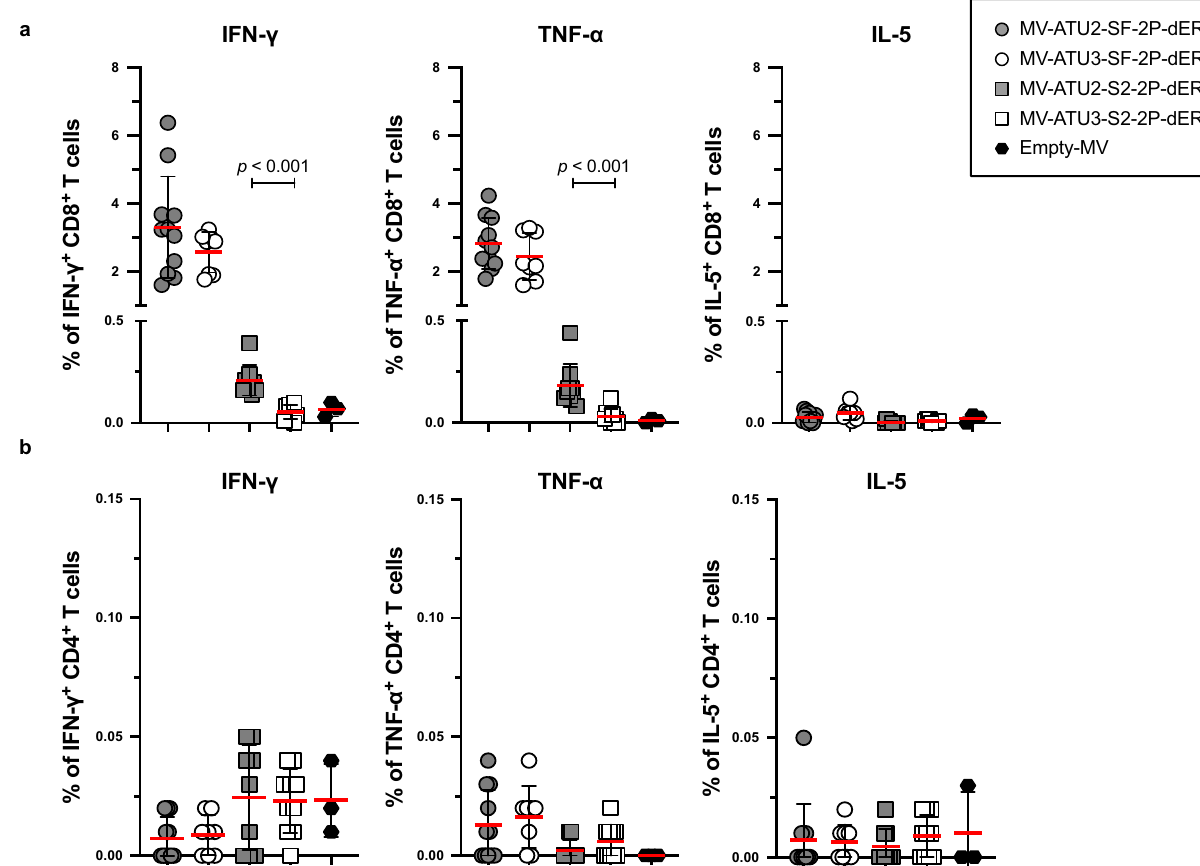
Fig. 5 Cytokine expression pro fi le of T cells. IFNAR − / − mice were immunized by intraperitoneal injection with 1 × 10 5 TCID 50 of MV-ATU2-SF-2P-dER, n = 11; MV-ATU3-SF-2P-dER, n = 8; MV-ATU2-S2-2P-dER, n = 9; MV-ATU3-S2-2P-dER, n = 9 and Empty MV, n = 3. Seven days after immunization, splenocytes were stimulated with S-speci fi c peptide pools. S-speci fi c a CD8 + and b CD4 + T-cells were stained for intracellular IFN γ , TNF α and IL-5. Data are represented as mean with line and error bars indicating ±SD. Signi fi cant differences between the groups were determined by the two-tailed Mann – Whitney